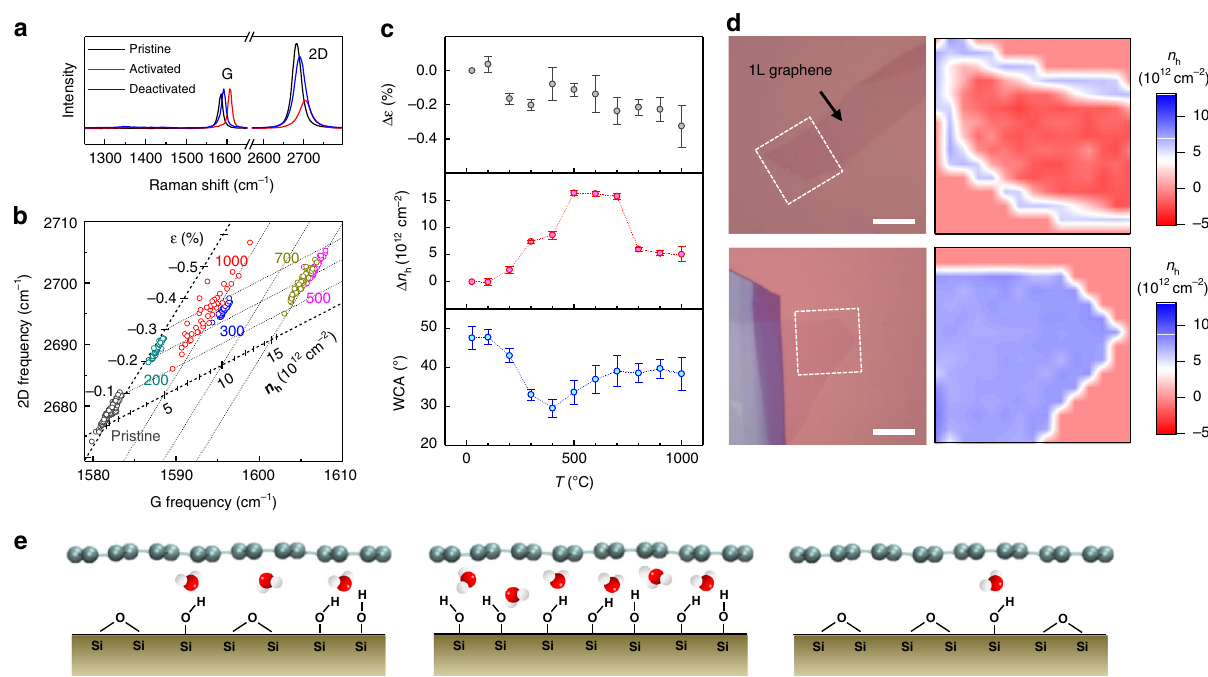
Fig. 3 Ampli fi cation and suppression of redox reactions. a Raman spectra of pristine (black), thermally activated (red; annealed at 500 °C), and deactivated (blue; annealed at 1000°C) 1L graphene (1LG silica ). b Correlation between G and 2D frequencies of 1LG silica samples annealed at various temperatures (in °C; given next to data). Lattice strain ( ε ) and electrical hole density ( n h ) were determined according to ref. 22 . c Changes in lattice strain (top) and hole- density (middle) of graphene; water-contact angle (bottom) of SiO 2 substrates as a function of annealing temperature (T). Error bars denote standard deviation. d Optical micrographs (left) and charge-density images (right) of 1LG silica samples prepared on diethyl zinc-treated (top) and non-treated (bottom) substrates. Both samples were activated by annealing at 400 °C. Scale bars: 10 μ m. e Schematic representation of air-equilibrated graphene – SiO 2 interface: pristine (left), hydroxylated by thermal activation (middle), and dehydroxylated by thermal deactivation (right). Equilibrium coverage of interfacial water was determined by effective hydrophilicity of SiO 2